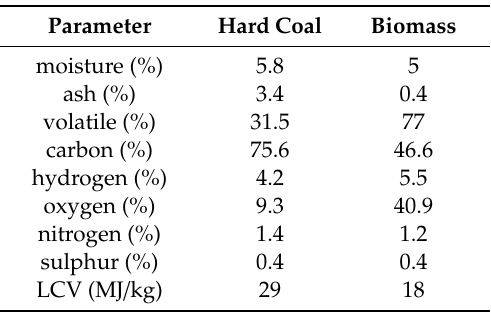
Table 1. Proximate and ultimate analysis of used